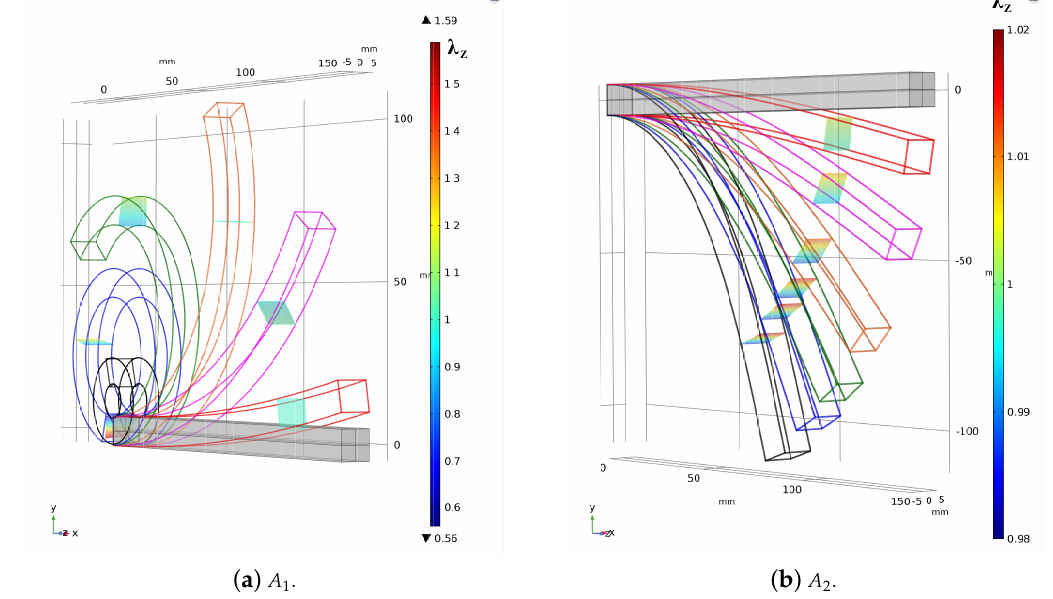
Figure 3. Sketch of the study cases: Reference and deformed configurations provided by the FE